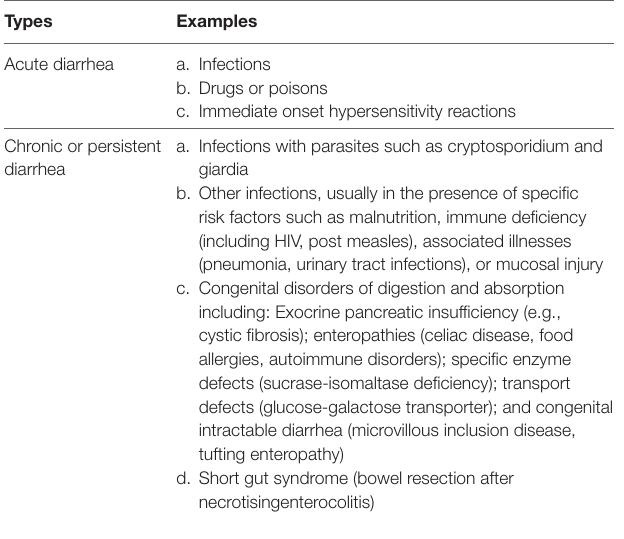
TABLe 1 | Causes of acute and chronic or persistent diarrheal disorders (32).